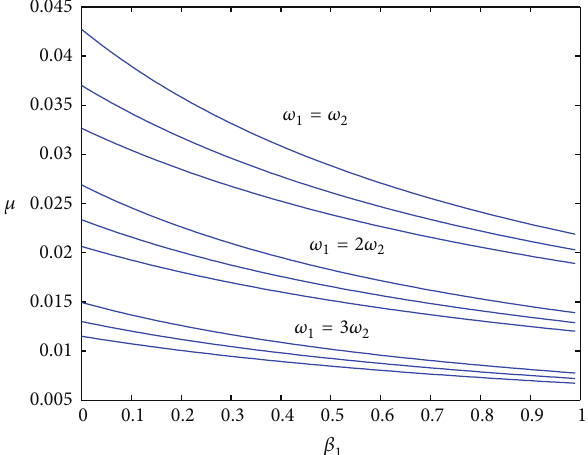
Figure 9: Correlation between 𝜇 and 𝐴 1 and 𝛽 1 = 0.01 , 𝛽 2 = 0.02 , and 𝐴 2 = 0.04 .